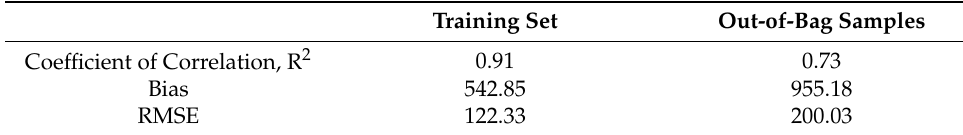
Table 1. Metrics of the training and out-of-bag data set.